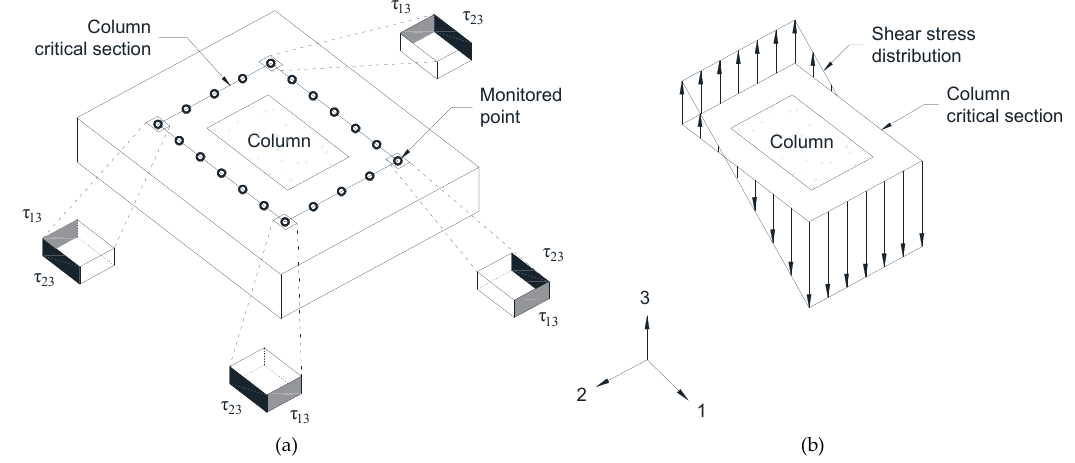
Figure 8. Punching shear stress along the critical section of slab-column connection. ( a ) Monitored points along critical section and ( b ) Assumed distribution of shear